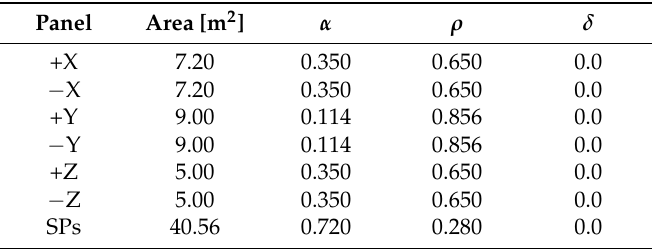
Table 1. The coarse values of optical (absorption α , reflectivity ρ , and diffusion δ ) and geometrical properties of satellite bus and SPs for BeiDou-3 I2-S